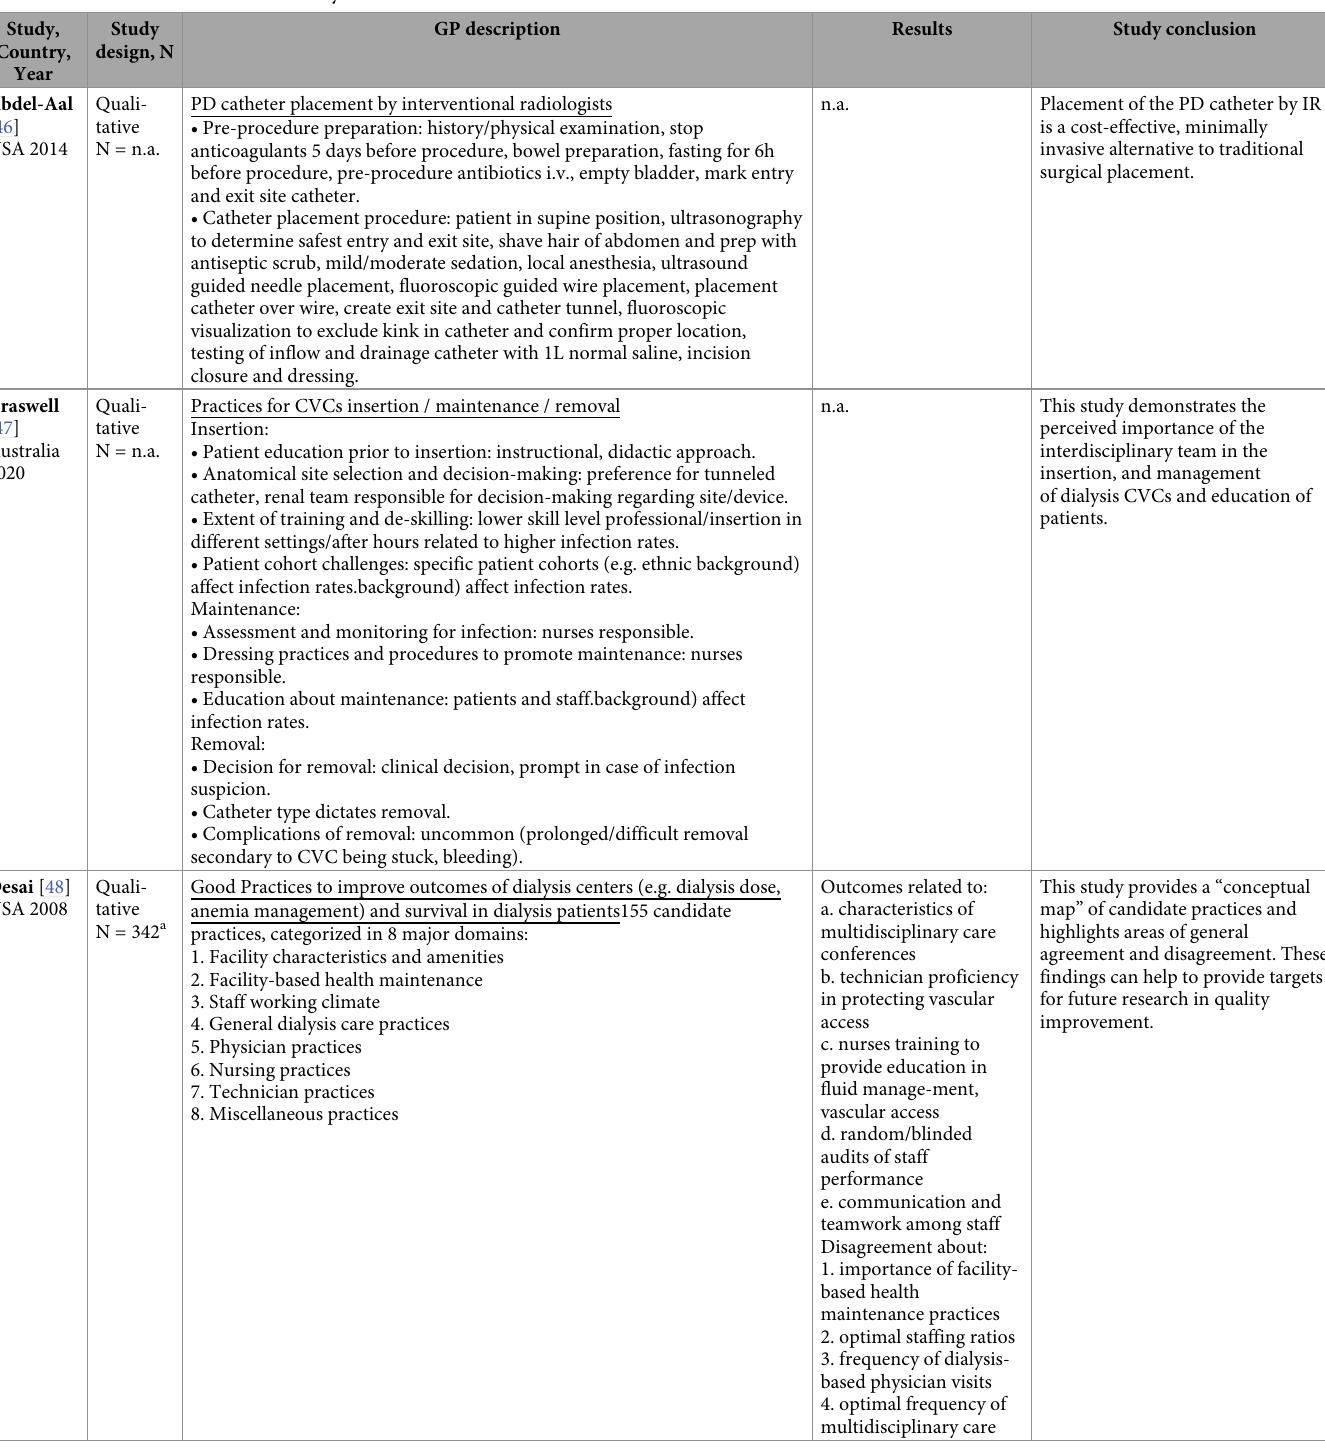
Table 3. Characteristics of studies on dialysis treatment. Study,